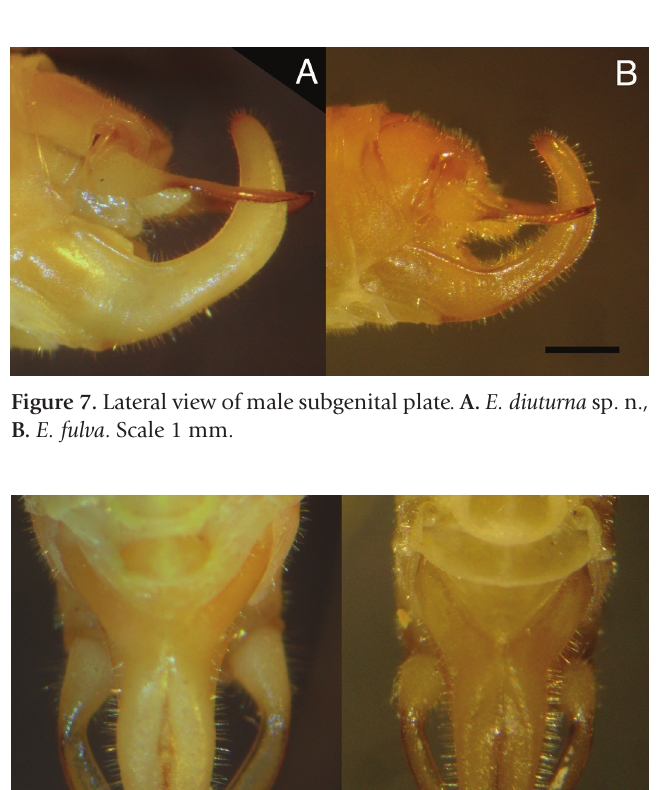
Figure 6. Stridulatory area with mirror at base of right tegmen. A. E. diuturna sp. n., B. E. fulva. Scale 1 mm.